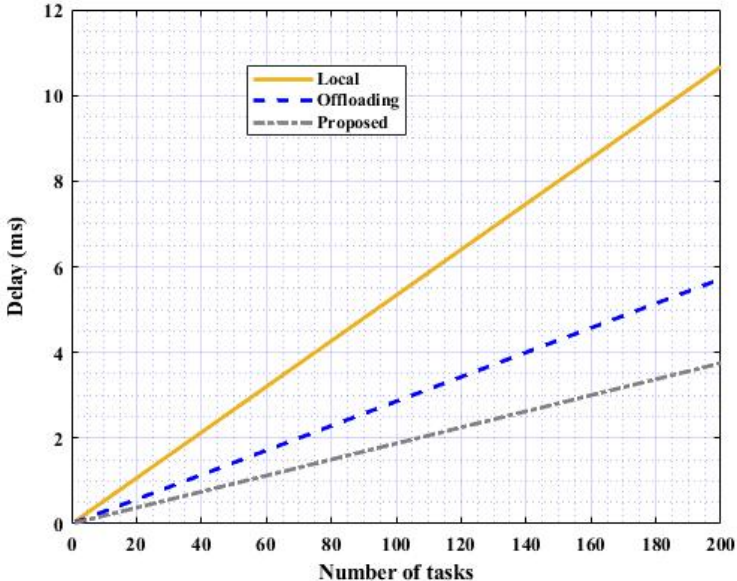
Figure 3. Performance vs. tasks—average delay.